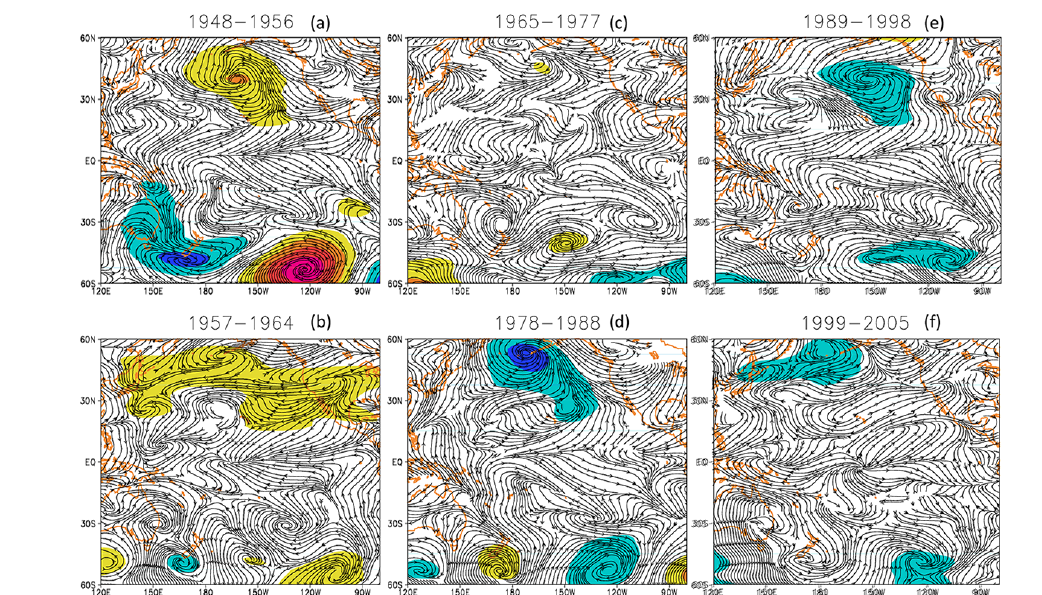
Figure 8. Pacific Ocean reconstructed height (shaded) and wind field anomaly over the Pacific Ocean at 1000hPa model level for the planetary wavenumbers 1–6. Shaded areas indicate the height anomaly exceeding the significant tests at the 90% confidence level (nega- tive anomaly: blue–purple shading; positive anomaly: green–yellow–red). (a) 1948–1956; (b) 1957–1964; (c) 1965–1977; (d) 1978–1988, (e) 1989–1998, (f) 1999–2005. Coastline in orange. Note that the domain shown is from 60 ◦ S to 60 ◦ N to highlight regions of wind driven forcing over the Pacific Ocean. When the streamlines converge, the water is generally rising or sinking (upwelling and downwelling).